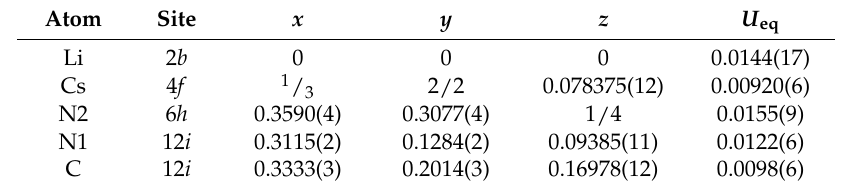
Table 4. Atomic coordinates and equivalent isotropic displacement parameters U eq (Å 2 ) of LiCs 2 [dca] 3 .